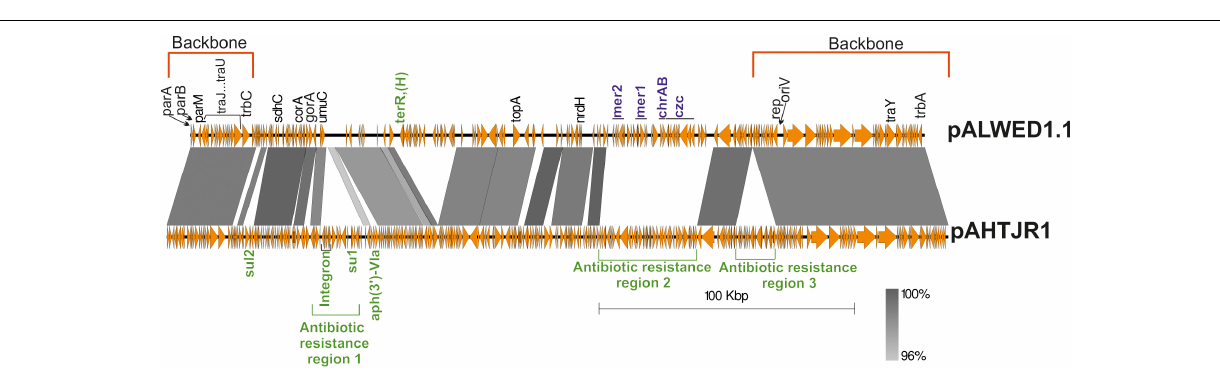
FIGURE 3 | Comparative linear map of plasmids pALWED1.1 and pAHTJR1. The location and polarity of genes and ORFs are shown with arrows. The extent of homologous regions is indicated in the dark gray shading. The backbones regions of plasmids are delimited by square red brackets and antibiotic resistance regions in pAHTJR1—by green. Antibiotic resistance genes are colored in green and genes of resistance to salts of heavy metals—in blue. Antibiotic resistance region 1 contains integron with the cassette genes arr-3 - (rifamycine resistance) and aacA4 (aminoglycoside resistance) and the gene aph(3 (cid:48)(cid:48) )-V1a (aminoglycoside resistance). Antibiotic resistance region 2 contains the genes oxa58 (carbapenem resistance), the msrE and mphE (macrolide resistance) and the floR (phenicol resistance). Antibiotic resistance region 3 contains the aminoglycosides resistance genes aph(3 (cid:48)(cid:48) )-1b and aph(6) -1d and tetracycline resistance genes tet (Y) and tetR . Other genes: sdhC , succinate dehydrogenase, cytochrome b556 subunit; corA , magnesium and cobalt transport protein CorA; gorA , glutathione-disulfide reductase; umuC , DNA polymerase V subunit UmuC; topA , topoisomerase IA; nrdH , putative NrdH-redoxin family